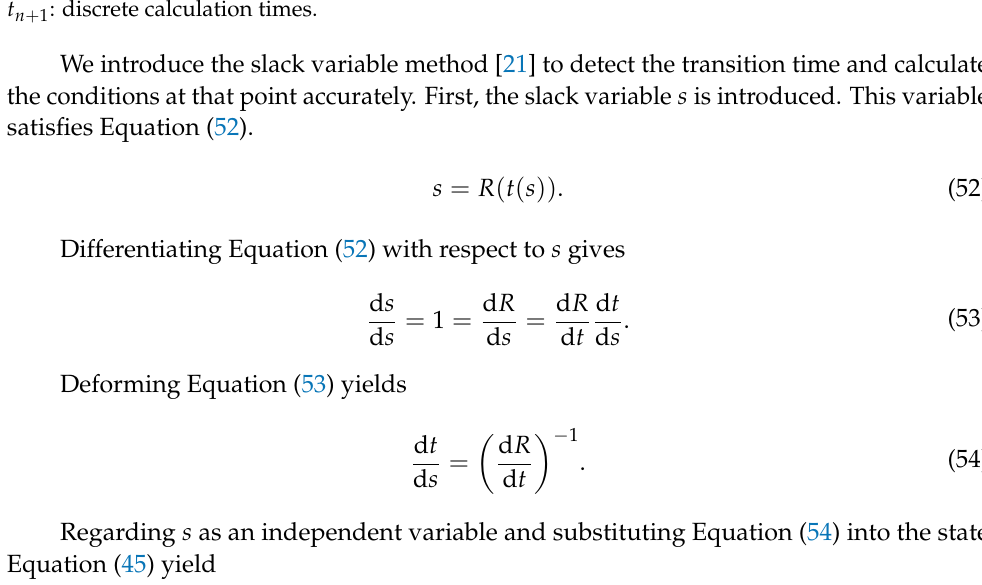
Figure 5. Exact state transition time and discrete calculation time. t e : exact transition time; t n − 1 , t n , t n + 1 : discrete calculation